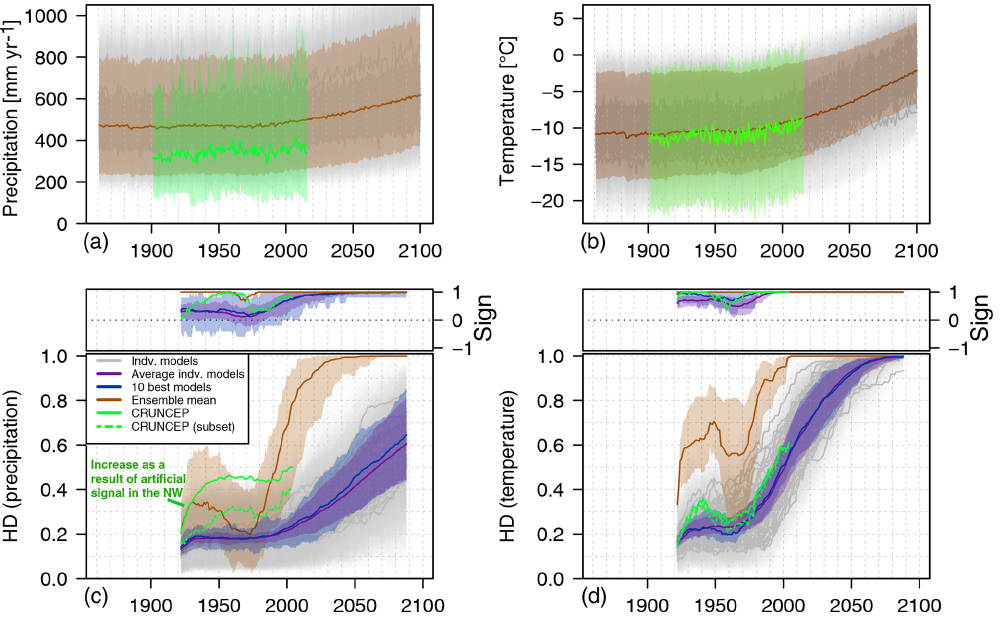
Figure 6. Area-averaged T and P signal evolution, emergence as the Hellinger distance (HD), and the sign of emergence. (a, b) Evolution of summed annual precipitation (a) and mean annual temperature (b) over the entire catchment (red outline in Fig. 1). (c, d) Evolution of the HD with the sign of emergence. Shading indicates the value range over all pixels in the study area. Dashed line for CRUNCEP shows HD evolution based only on the five pixels where meteorological stations cover more than 10 years in the reference period to eliminate data issues; see also the text and Supplement for data issues of CRUNCEP. The smoothed signal of the ensemble mean (a, b) results in a strong and early emergence (c, d) that is not seen in any of the individual